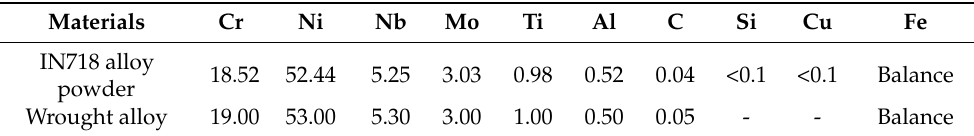
Table 1. Chemical composition of IN718 alloy powder and the wrought alloy (wt.%).